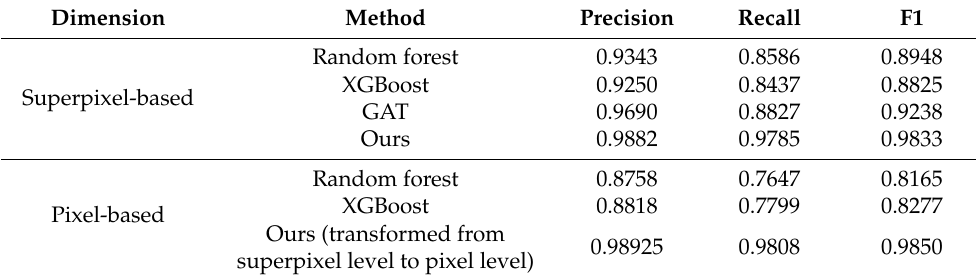
Table 2. Performance evaluation for study area